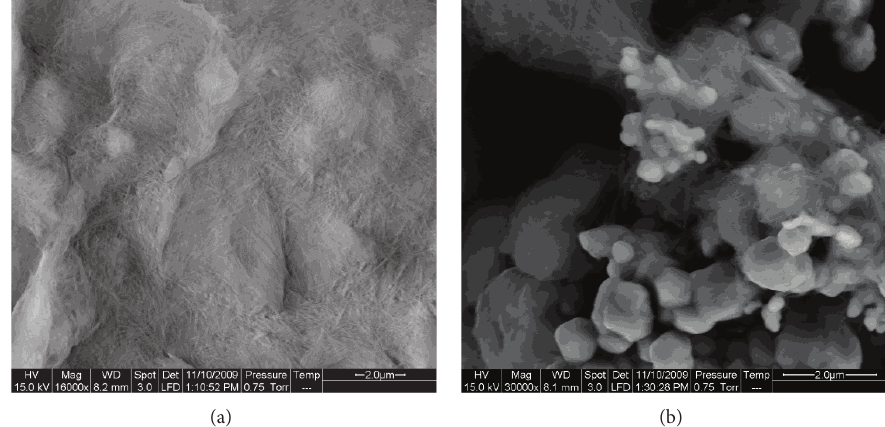
Figure 6: The change of scanning electron microscope photograph of palygorskite processed with magnesium oxide. (a) SEM micrograph of original unmodified palygorskite. (b) SEM micrograph of palygorskite modified adding